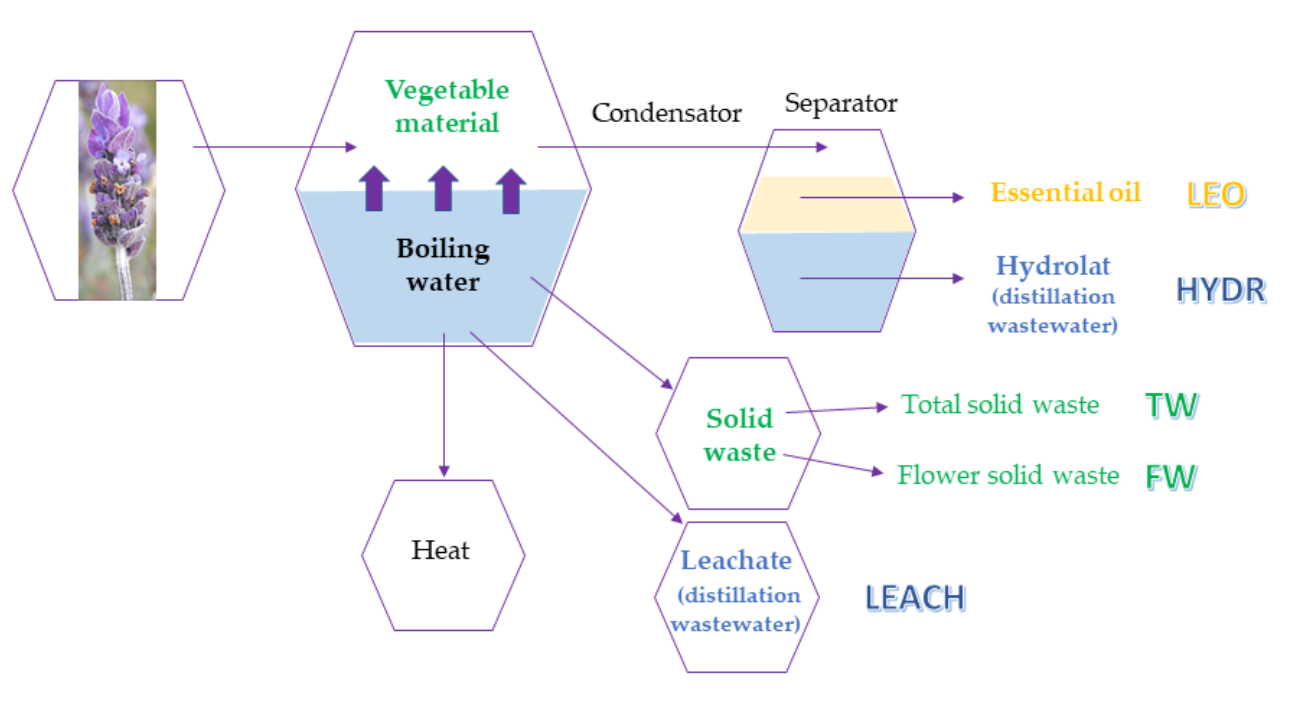
Figure 1. Lavender steam distillation scheme.